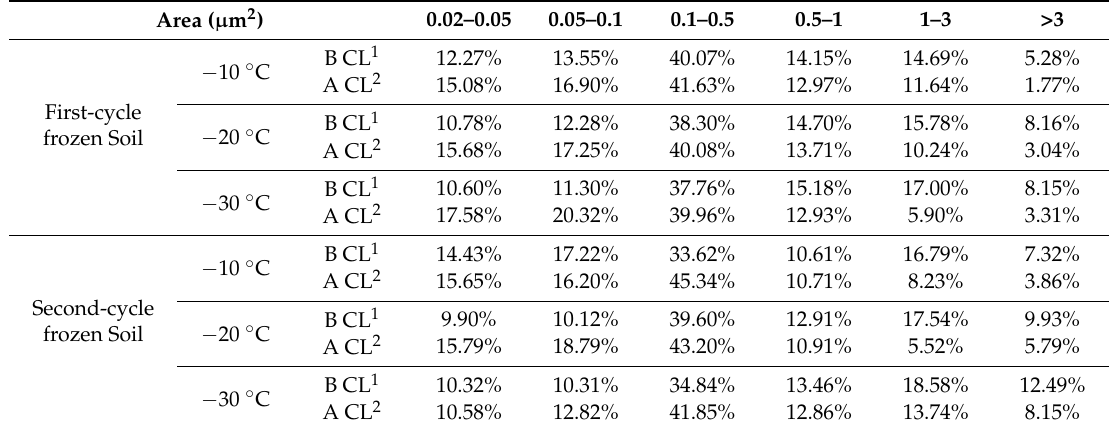
Table 3. Distribution of pore area.